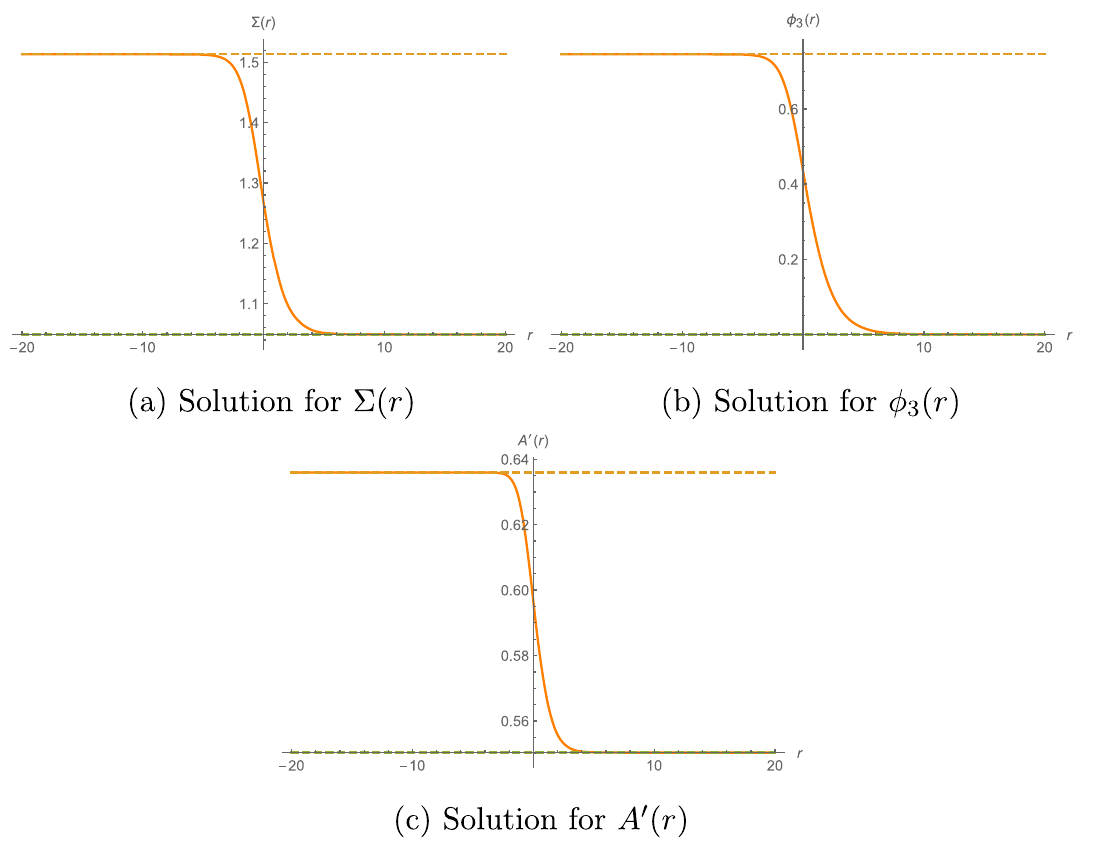
Fig. 2 An RG flow from N = 4 AdS 5 critical point with SO ( 2 ) D × SO ( 3 ) diag symmetry to N = 2 AdS 5 fixed point with SO ( 2 ) diag symmetry in the IR with g = 1, ρ = 3 and ζ = 1